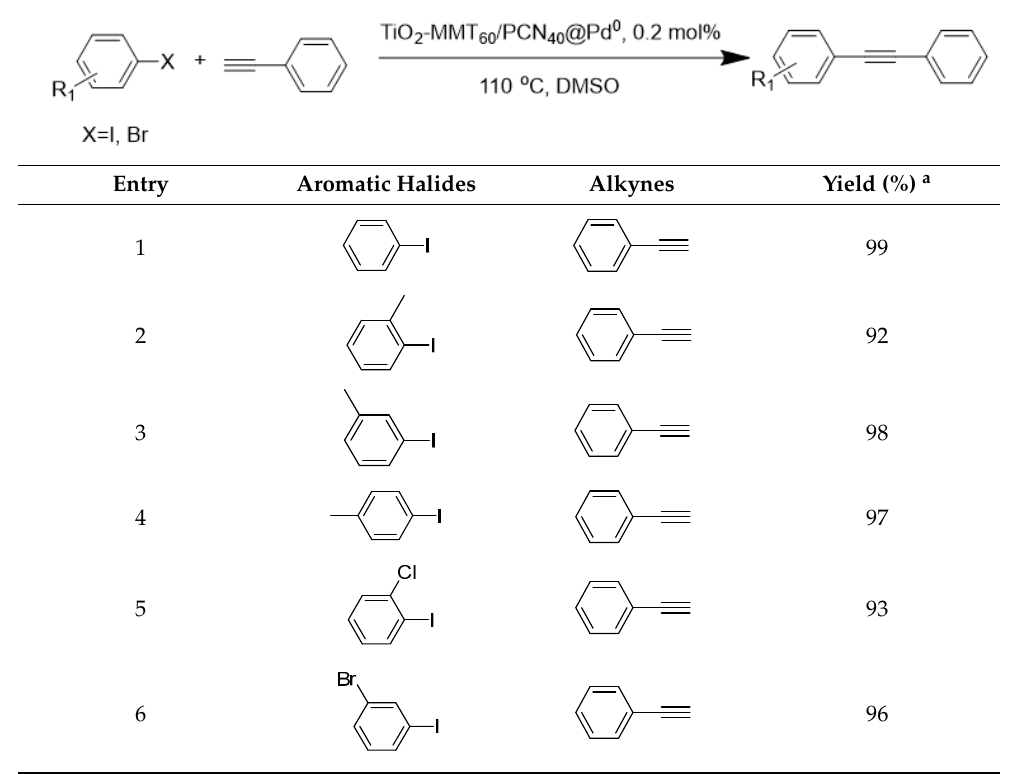
Table 4. Catalytic performance of TiO 2 -MMT 60 /PCN 40 @Pd 0 nanocomposites applied in Sonogashira coupling reactions between aromatic halides and alkynes.